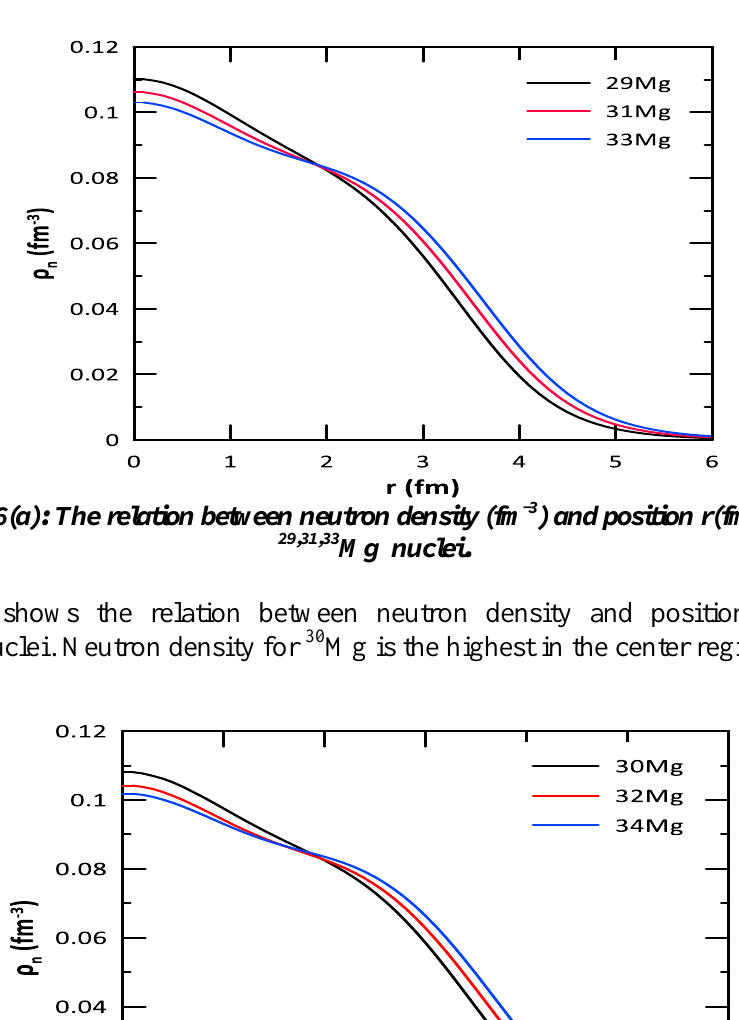
Fig. 6(b): The relation between neutron density (fm -3 ) and position r(fm) for 30,32,34 Mg